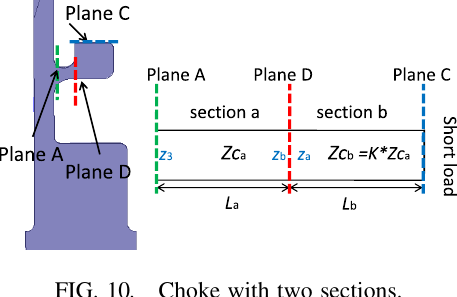
FIG. 10. Choke with two sections.